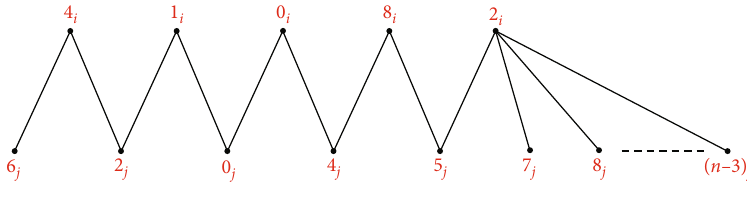
Figure 23: The labelling for ð C